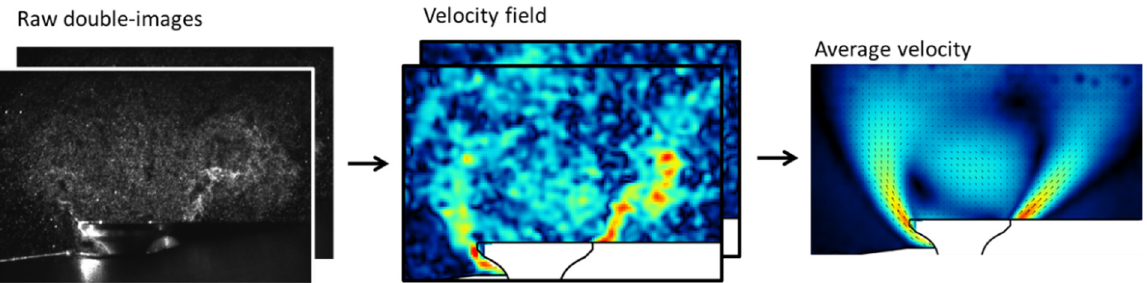
Figure 5. Example of raw double-images ( left ), instantaneous velocity fields ( middle ), and average velocity field ( right ).